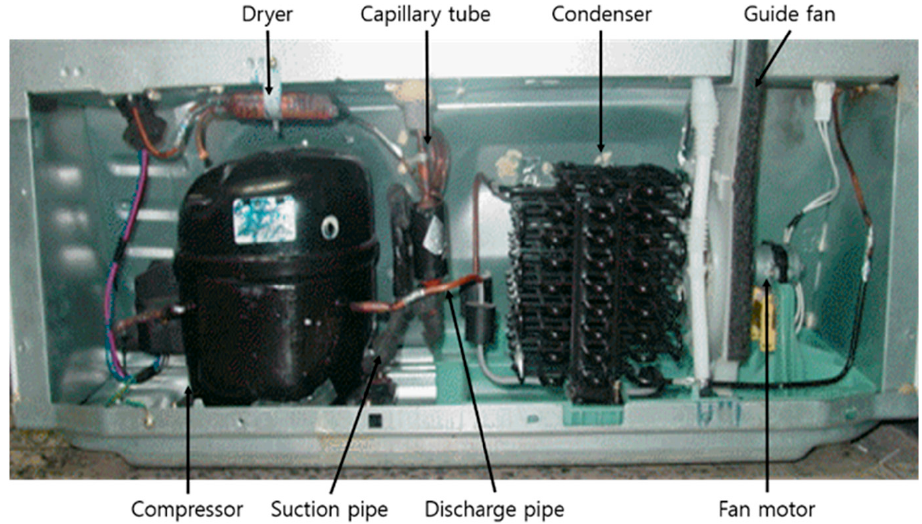
Figure 1. Component arrangement of the mechanical chamber room (MCR).